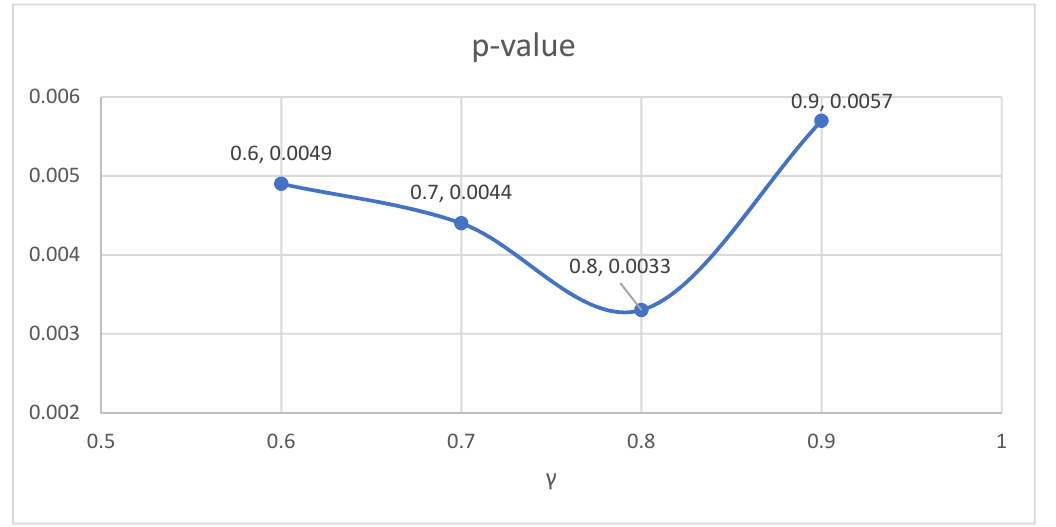
Figure 7. p -value results when γ varies from 0.6 to 0.9 under the ALP.